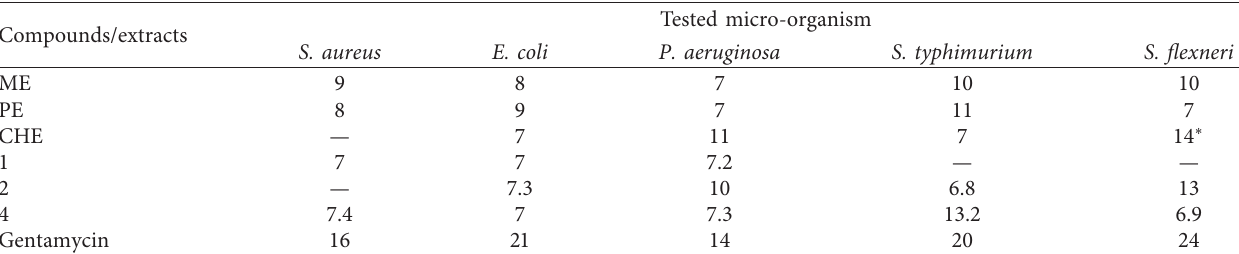
Figure 3: Key HMBC (curved arrow) and 1 H- 1 H COSY (bold line) correlations of compound 3 . Table 2: Bacterial growth inhibition zone in diameter (mm) of crude extracts (20 μ g/mL each) and isolated compounds ( 1 , 2 , and 4 ) (10 μ g/ mL